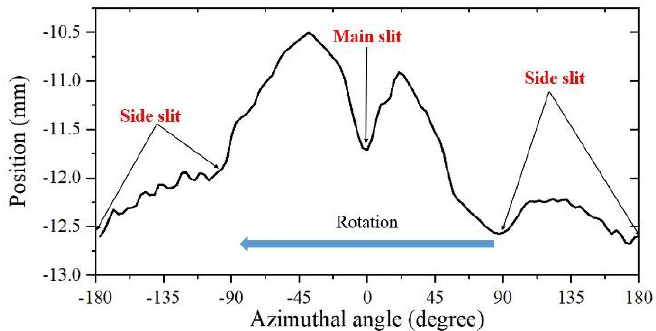
Figure 10. Three-phase line along the azimuthal direction. The rotation direction is from right to left. Azimuthal angle of the main slit is regarded as 0°. The angles of the three side slits are −90°, 90°, and 180°, respectively.